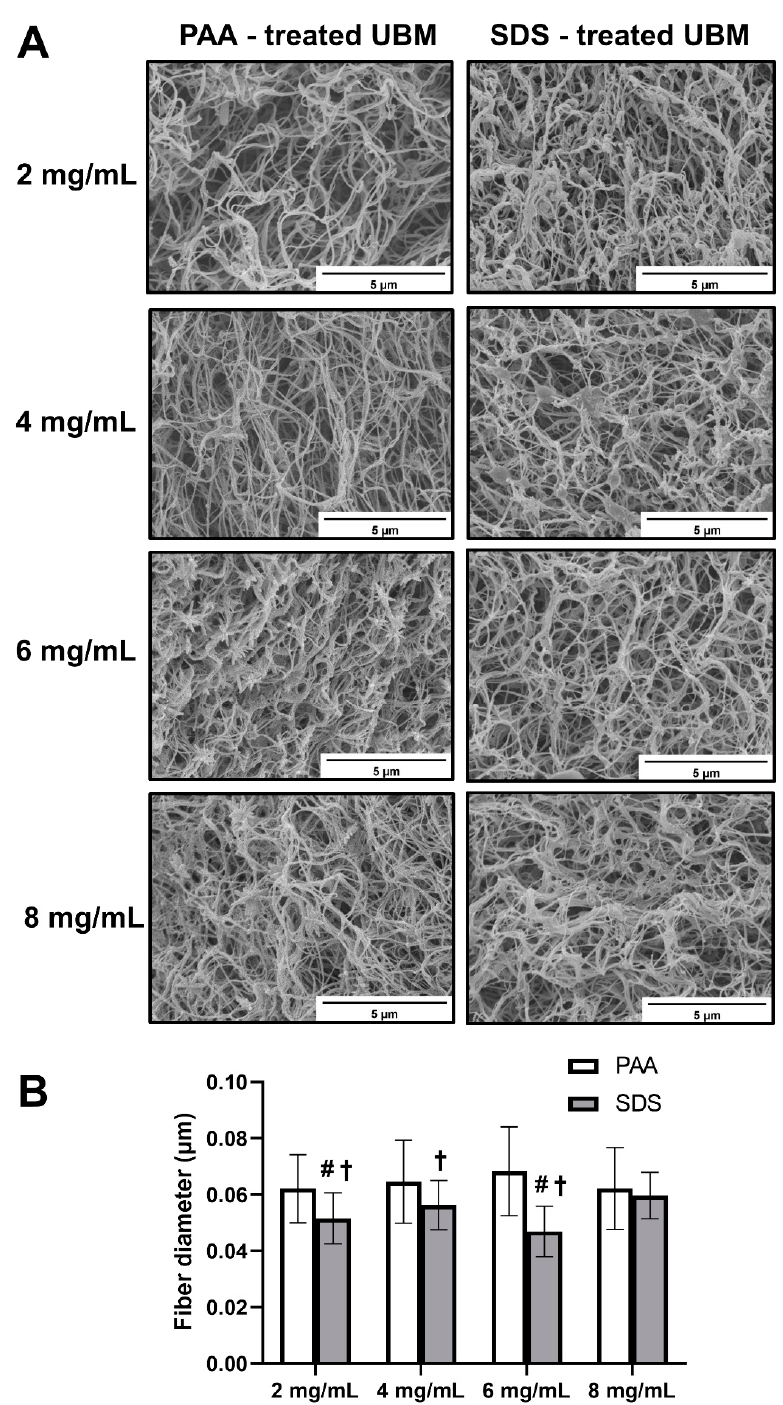
Figure 5. Hydrogel surface morphology of hydrogel from PAA and SDS groups. Scanning electron micrographs of UBM hydrogel surface ( A ) (scale bar 5 µ m). Fiber size ( B ) of hydrogels. # denotes statistically di ff erence from the 8 mg / mL concentration of the same decellularization group type, and † denotes statistically di ff erence between PAA and SDS groups at the same concentration ( p < 0.05).